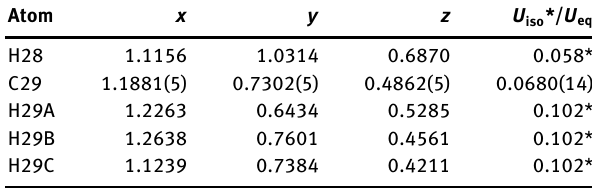
Table 2: Fractional atomic coordinates and isotropic or equivalent isotropic displacement parameters (Å 2